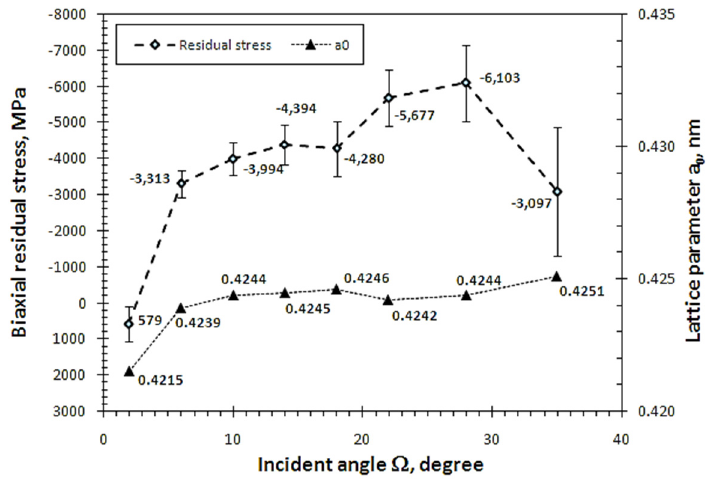
Figure 8. Effect of incident angle Ω on the residual stress and stress ‐ free lattice parameter measured following the GIXRD mode.